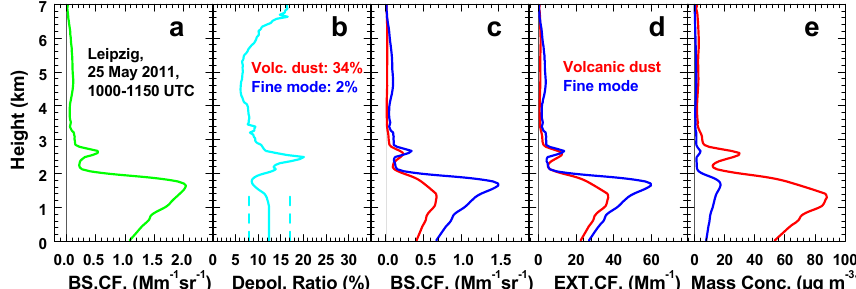
Fig. 5. Same as Fig. 2 except for Grimsv¨otn volcanic aerosol observed at Leipzig in May 2011. Dashed lines in (b) indicate the uncertainty range of derived